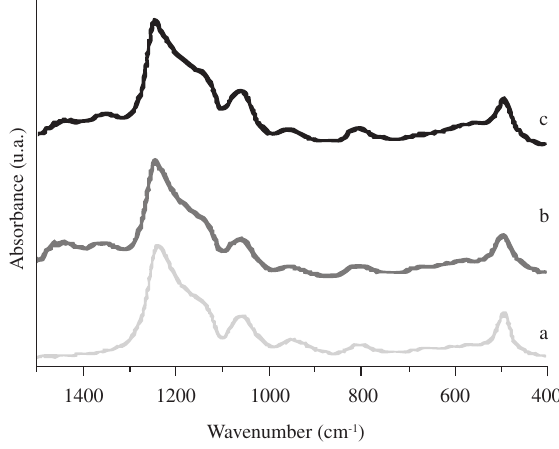
Figure 3. FTIR spectra of a) unary film; b) binary film; c) ternary film at 200 °C for 1 hour at 75° of incidence.